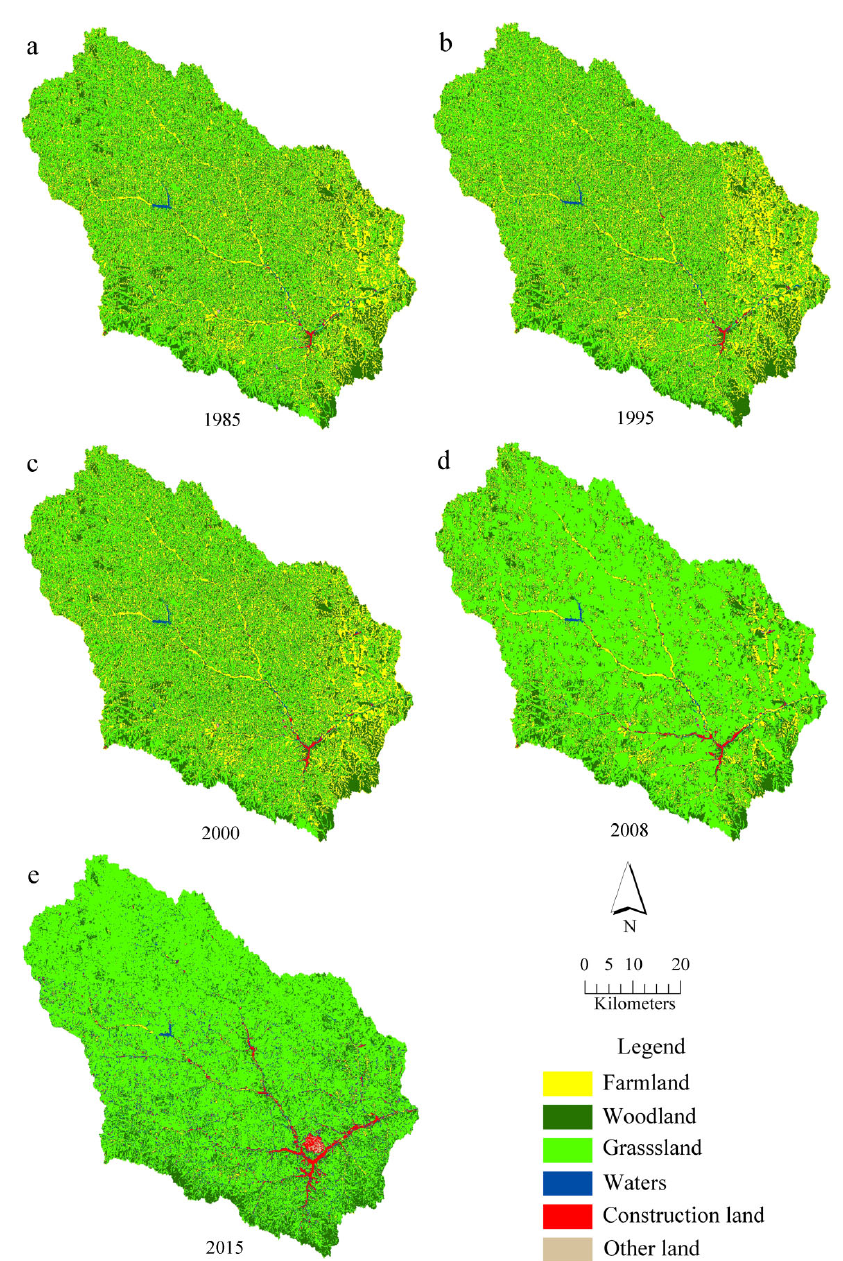
Figure 5. Composition of land ‐ use from 1985 to 2015: ( a ) 1985; ( b ) 1995; ( c ) 2000; ( d ) 2008; ( e ) 2015. Table 3. Land ‐ use transfer matrix from 1985 to 2015 (km 2 ).